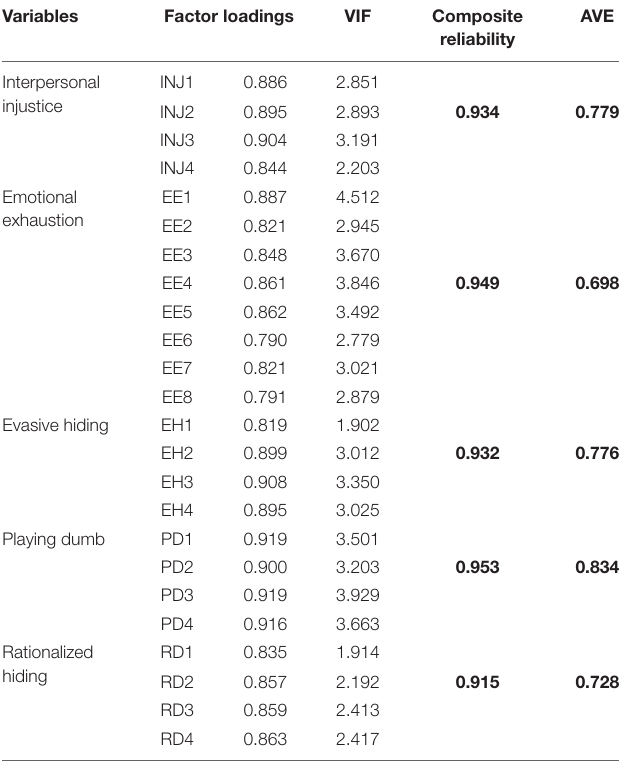
TABLE 3 | Model assessment (direct model).